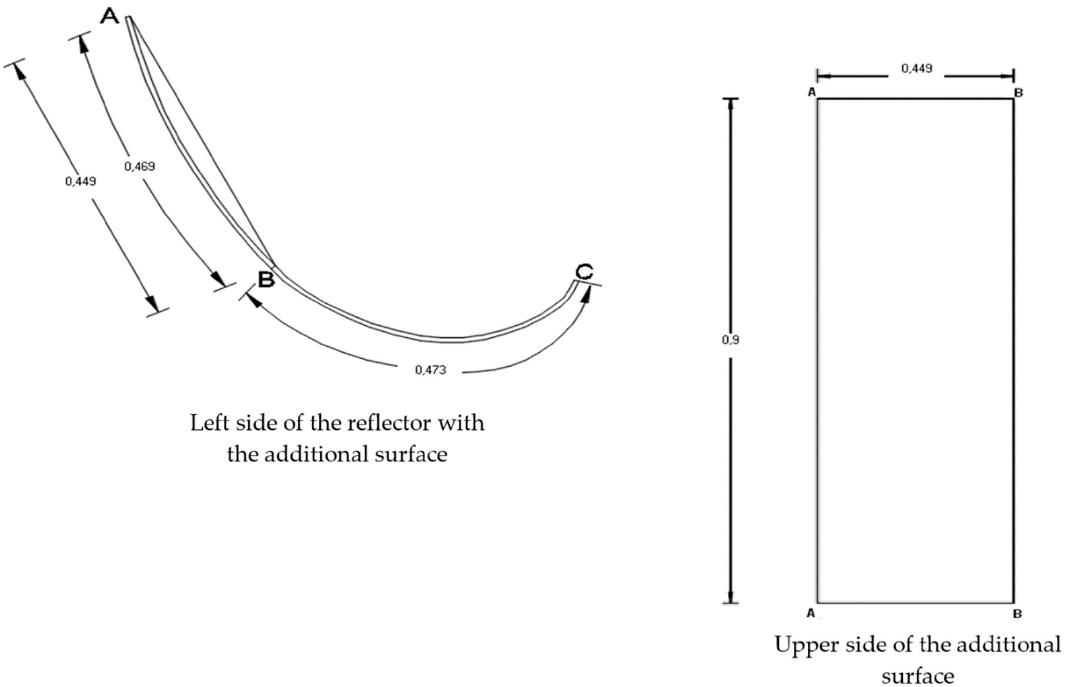
Figure 7. Dimensions (in m) for the additional surface, which will be hypothetically located in the left part of the reflector (CAD environment).